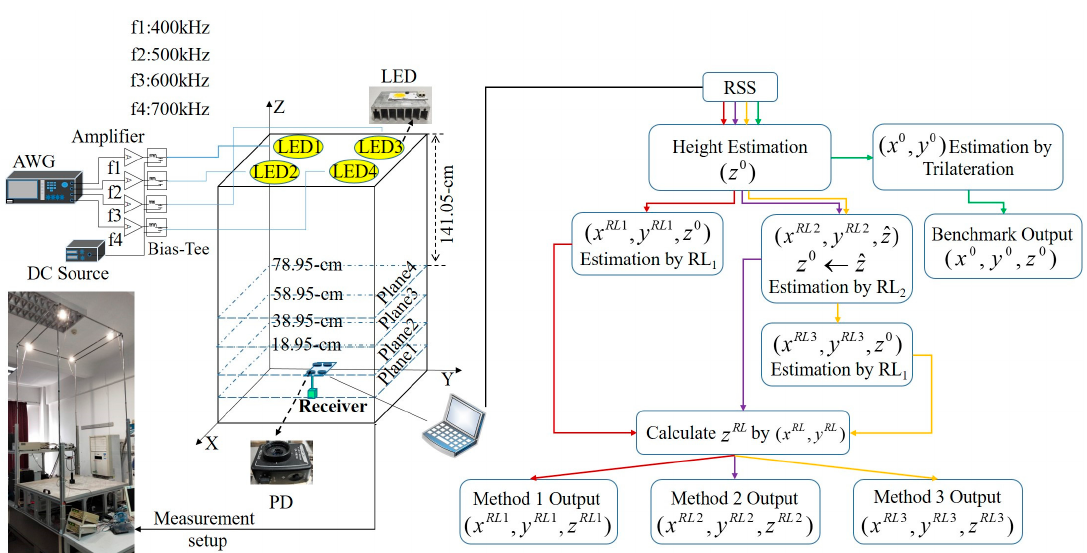
Figure 1. The 3D VLP system setup and the signal processing flow. The green, red, purple, and yellow lines represent the flow for the Benchmark, Method 1, Method 2, and Method 3, respectively. The inset shows the picture of our testbed.